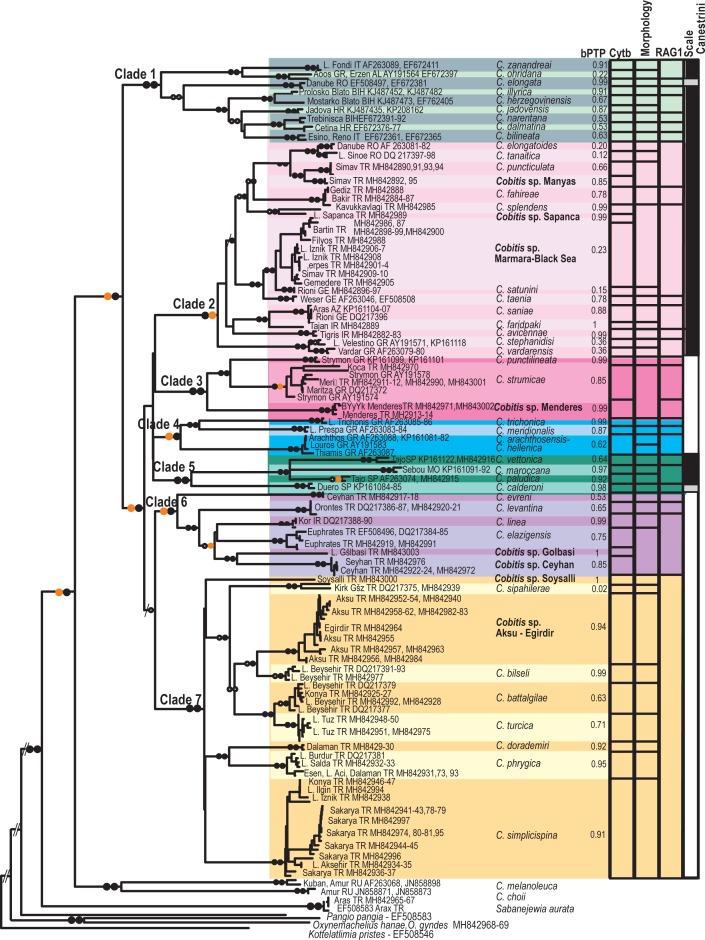
Phylogenetic tree for Western Palearctic Cobitis based on the complete cyt b dataset (N = 199).Symbols on branches correspond to bootstrap values (BT) for RAxML and Bayesian posterior probability support (pp), respectively: Black dots >95 BT/pp, orange dots 85–95 BT/pp, grey dots <85–50 BT/pp, / No support. To the right of the phylogeny, the column labelled bPTP represents Bayesian posterior probabilities (pp) for hypothesized species obtained by bPTP analyses. The coloured bars to the right represent hypothesized species and species groups based on the BT/pp values of the complete cyt b and RAG1 datasets and identified species according to their morphology with the disclosed bar Scale Canestrini indicating the number (0–2) of lamina circularis or scale of Canestrini exhibited by Cobitis males: 0 grey, 1 black, 2 white. The seven major clades (Clades 1–7) obtained in the mtDNA analysis are represented by the different colours following those shown in Fig 1. Individual species within clades are identified using darker to lighter shades of the corresponding clade colour.